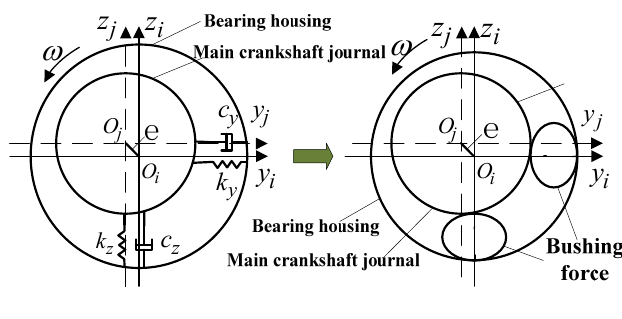
Fig.7. Schematic diagram of flexible